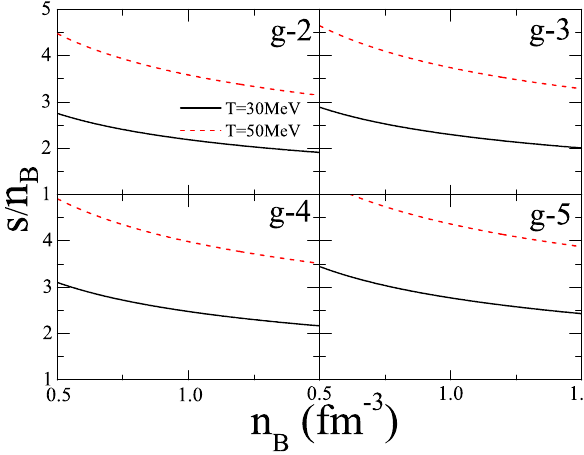
Fig. 2 Pressureasafunctionofbaryondensityindifferenttemperature cases